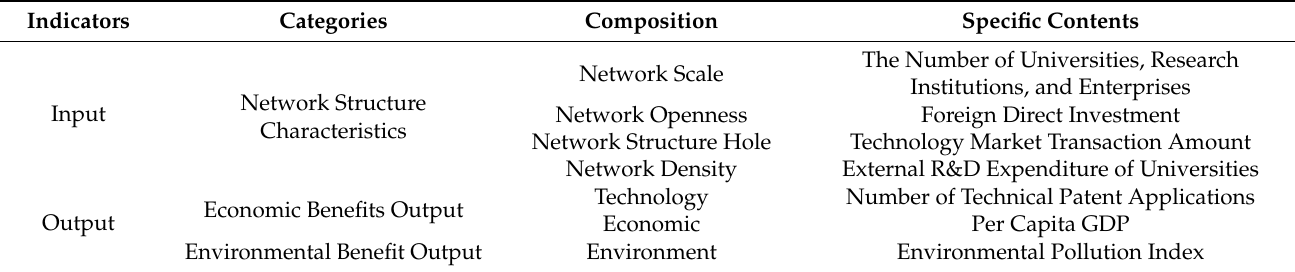
Table 1. Evaluation index system of green innovation